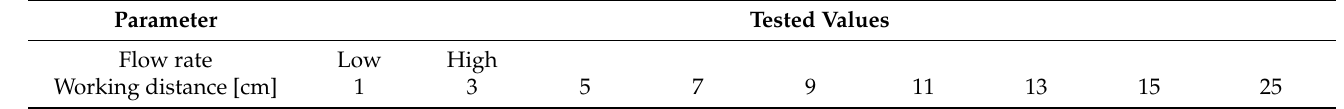
Table 1. Overview of investigated spray parameters for the evaluation of the spraying pattern.